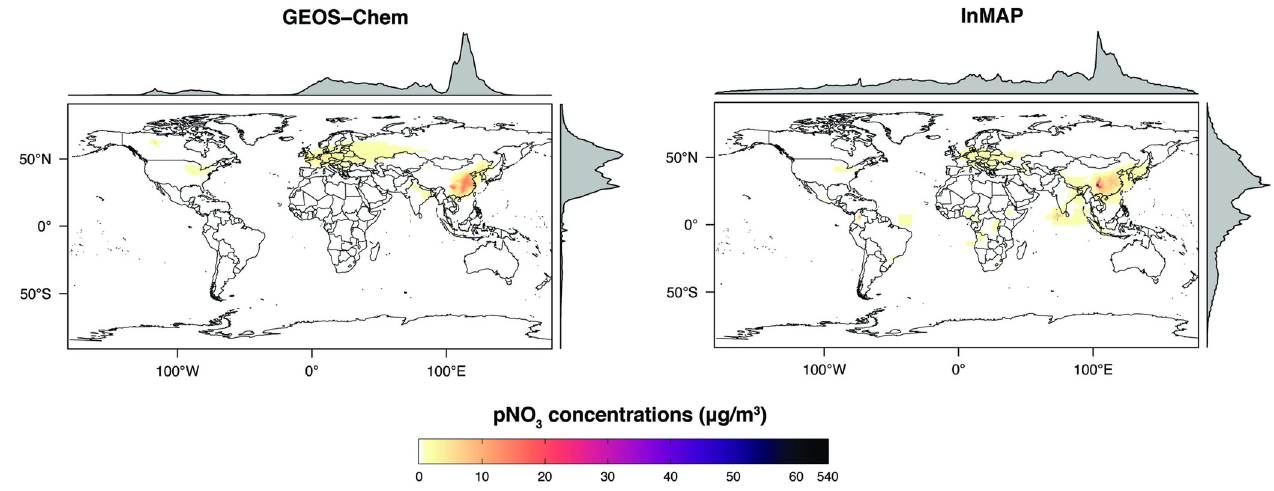
Fig 4. Global InMAP and GEOS-Chem annual-average ground-level pNO 3 concentrations.